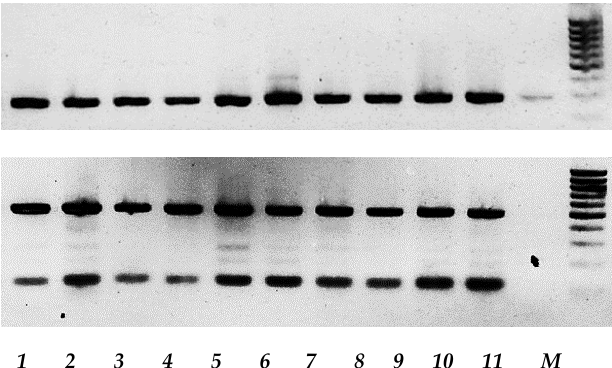
Figure 8. Molecular characterization of DI-RNAs generated by vaccine strain L-16 of MV. cDNA amplified with L-16-specific RT-PCR (upper panel) or DI-RNA-specific RT-PCR (lower panel), and analyzed by agarose gel electrophoresis. The lines correspond to the following cells: 1—mel Il + L-16, 24 h p.i., 2—mel Il + L-16, 48 h p.i., 3—mel Mtp + L-16, 24 h p.i., 4—mel Mtp + L-16, 48 h